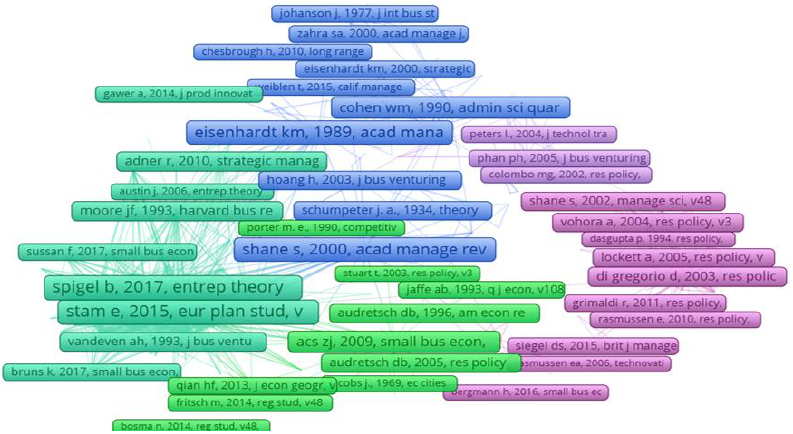
Figure 2. Network co-citation analysis (VOSviewer).